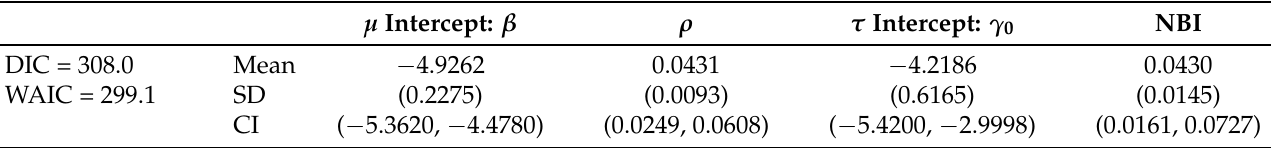
Table 7. Parameter estimates, standard deviations and 95% credible intervals for the estimated means in parenthesis, DIC and WAIC values, for the generalized spatial conditional normal Poisson model fitted to the Colombian infant mortality rates data